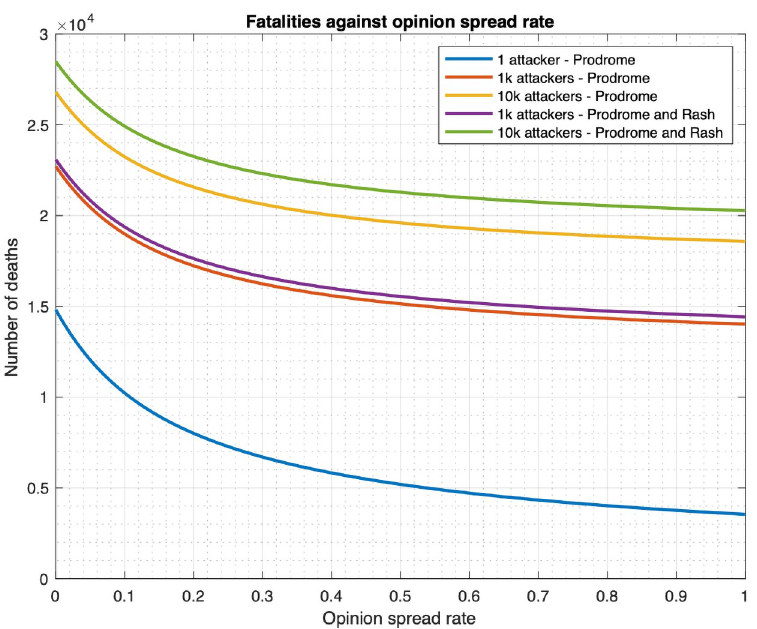
Fig 7. Fatality versus opinion spread rate for different numbers and stages of initial infections in a single cluster (both drug and vaccine scenario).